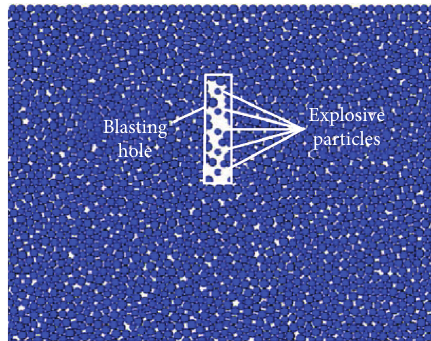
Figure 6: Cylindrical charge